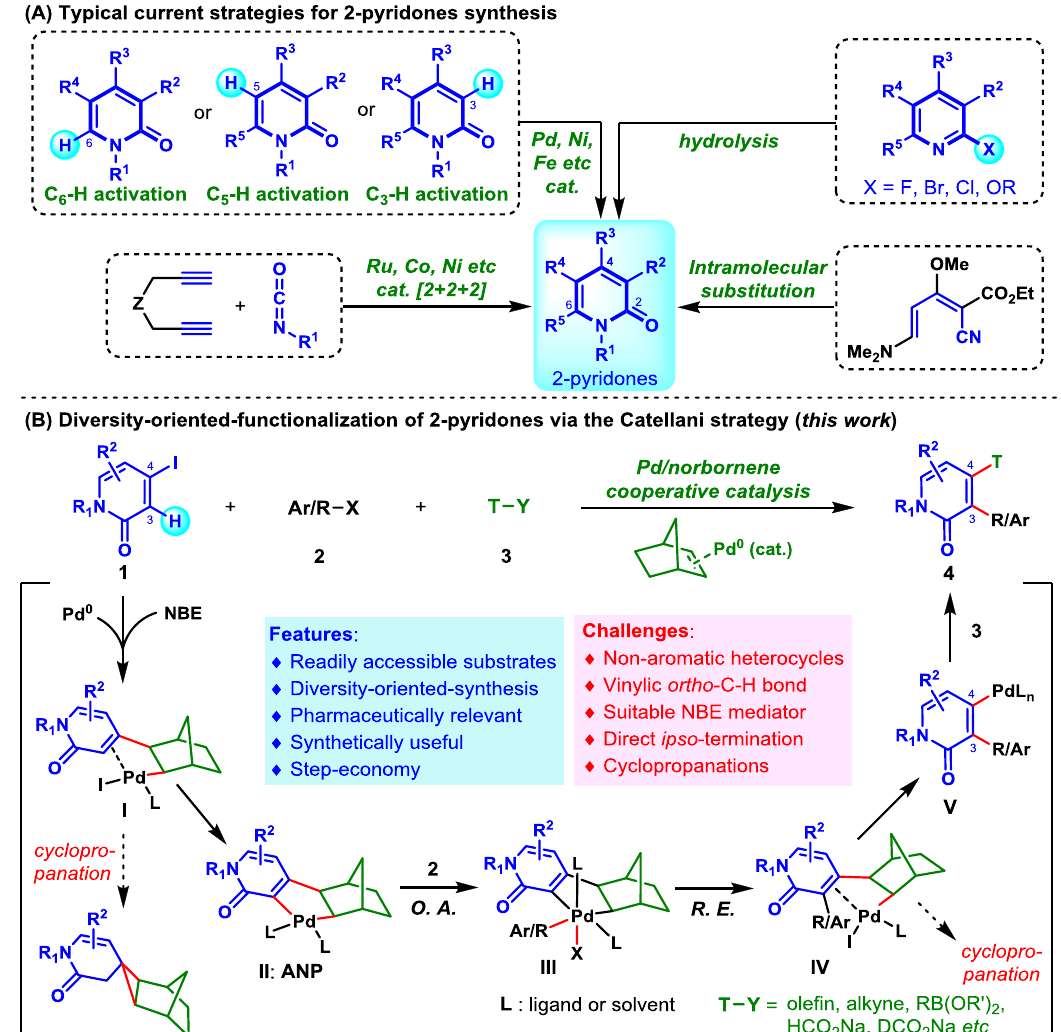
Fig. 2 Strategies for 2-pyridones synthesis. A Typical current strategies for 2-pyridones synthesis. B Diversity-oriented-synthesis of 2-pyridones via the Catellani